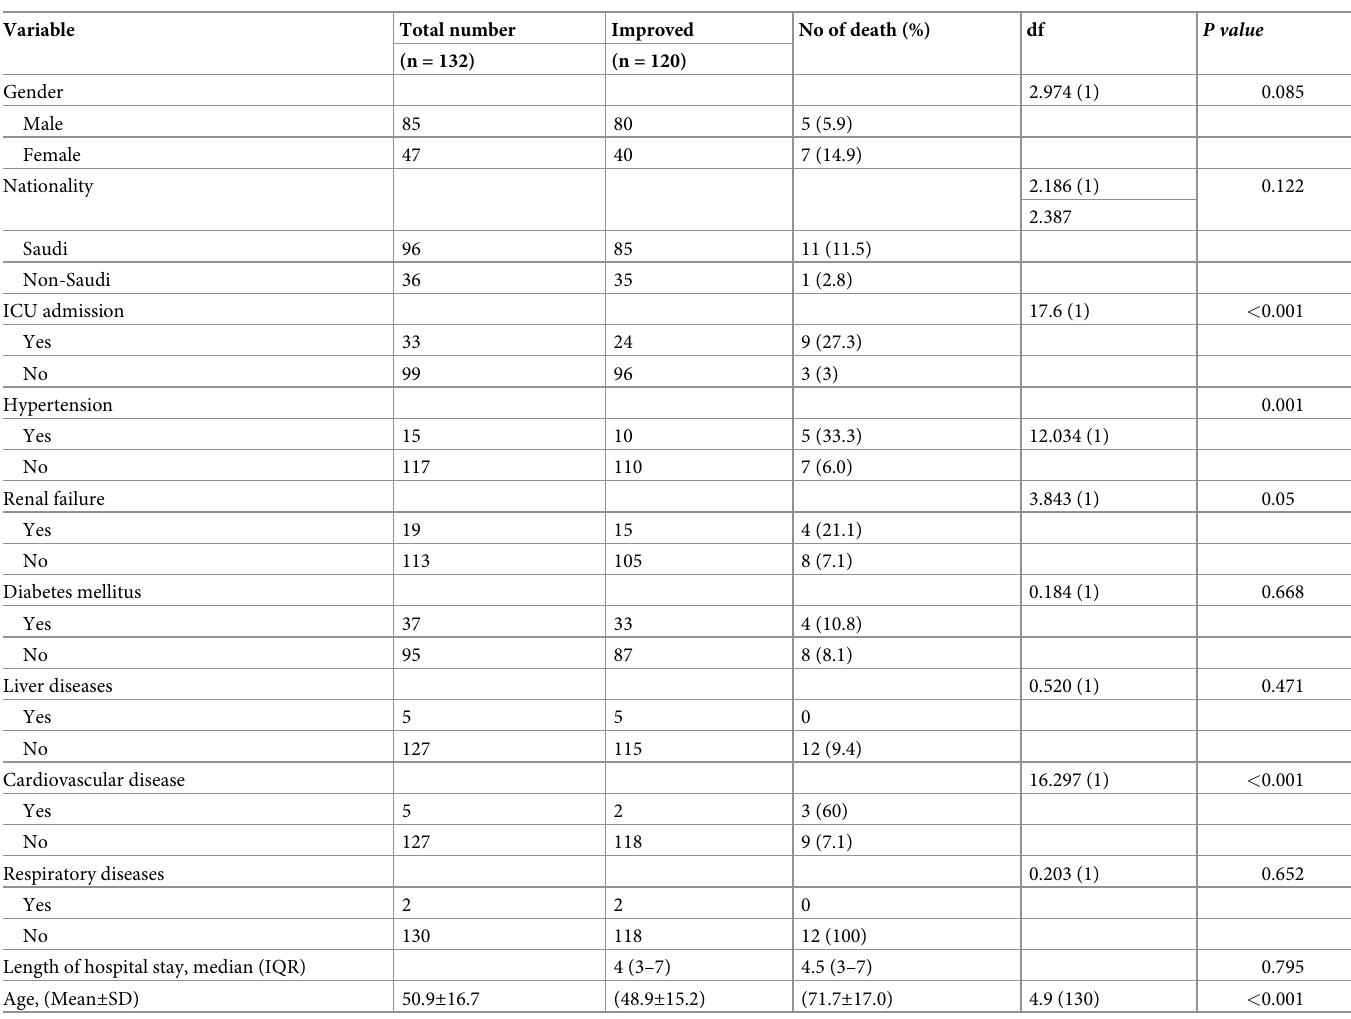
Table 3. Factors associated with COVID-19